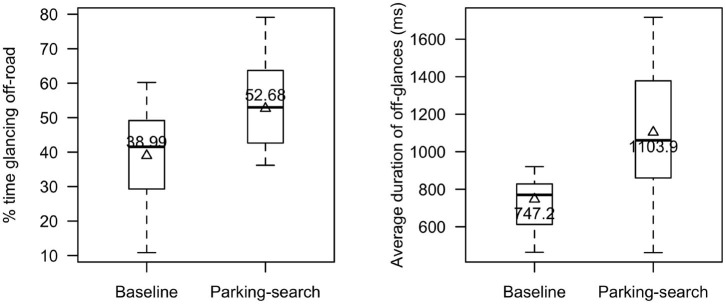
Percent time glancing off-road and average duration of off-road glances.